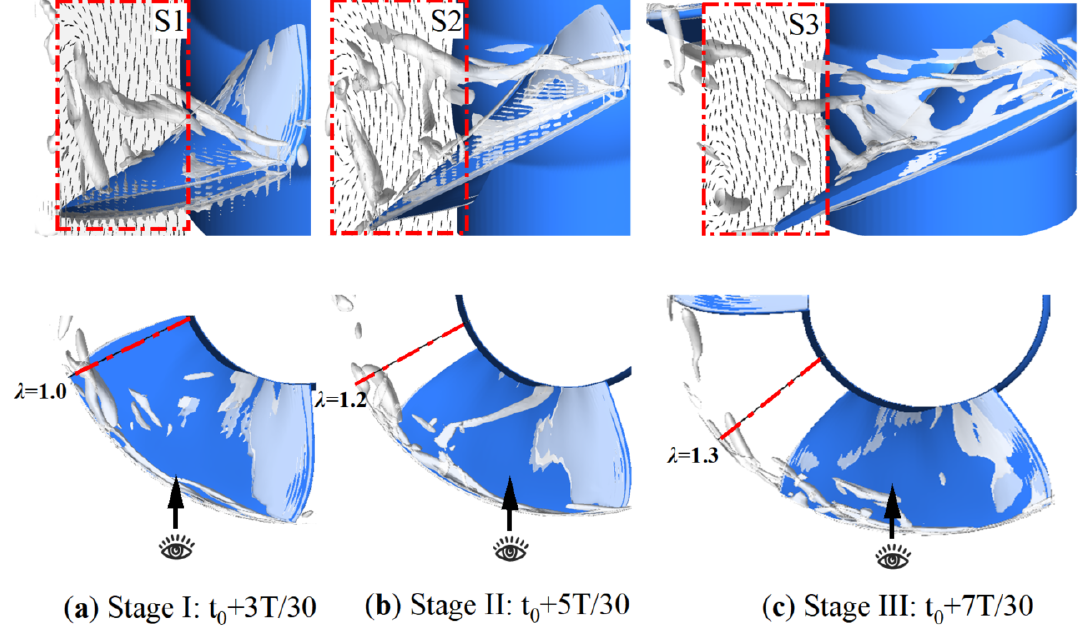
Figure 14. Schematic diagram of the physical quantity of the sampling surface at different moments (swirling strength isosurface Sw = 1000 s − 1 (white), Q = 0.8 Q BEP , σ = 0.35).